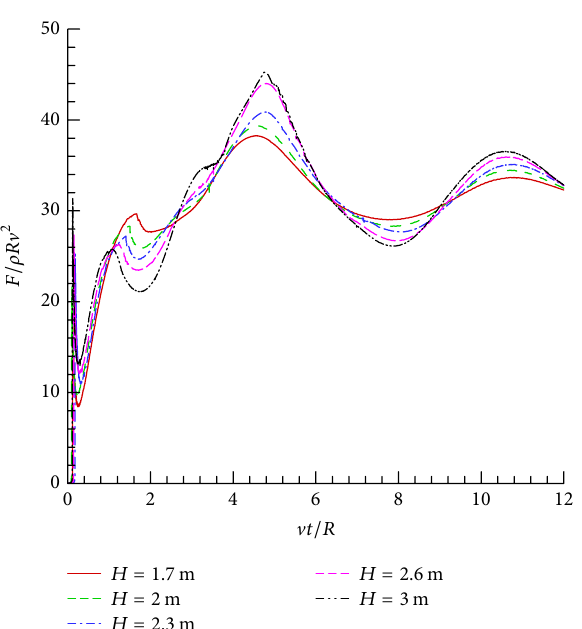
Figure 14: Fluid forces with different cylinder radiuses.